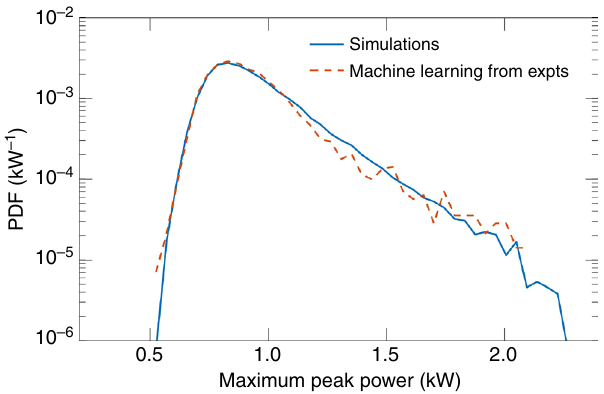
Fig. 7 Probability density function (PDF) of the maximum intensity of the temporal intensity pro fi les predicted by the machine learning algorithm from an ensemble of 3000 single-shot experimental spectra (dashed red line) compared with the PDF calculated from the simulated time-domain data (solid blue